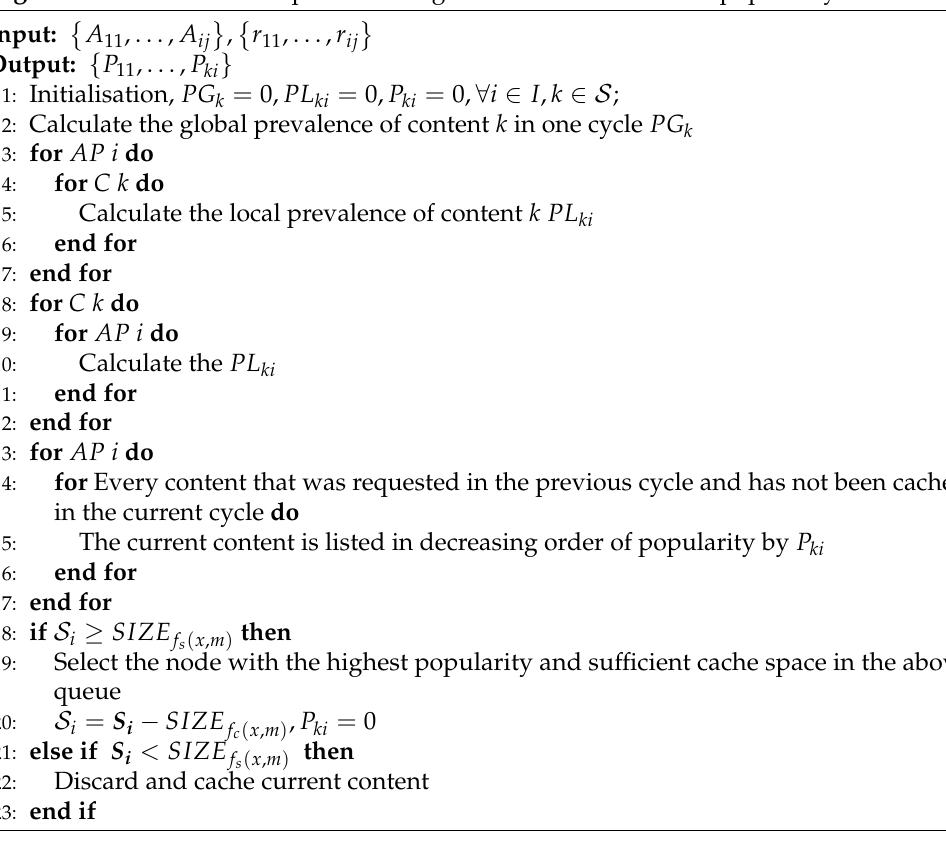
Algorithm 1 Content cache placement algorithm based on content